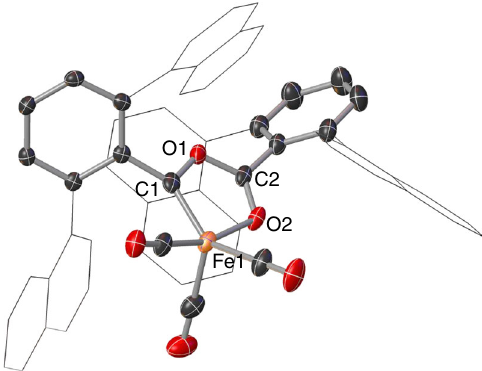
Fig. 3 Molecular structure of 4 . Structure of 4 with anisotropic displacement ellipsoids set at 50% probability. Naphthyl groups shown as wireframe, hydrogen atoms and one molecule of Et 2 O solvent have been omitted for clarity. Selected bond distances (Å) for 4 : Fe1 – C1 1.840(3), Fe1 – O2 1.9572(18), Fe1 – C3 1.830(3), Fe1 – C4 1.753(3), Fe1 – C5 1.849(3), C1 – Fe1 – O2